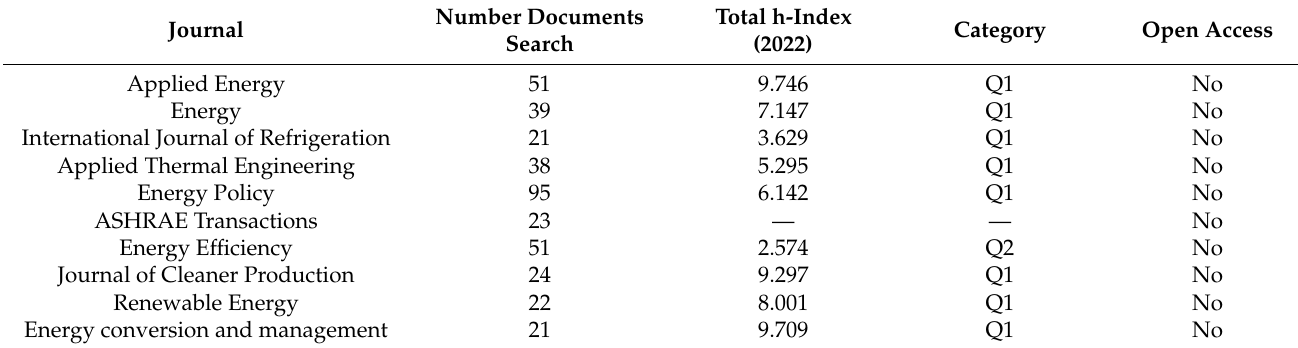
Table 4. The journals most used and their